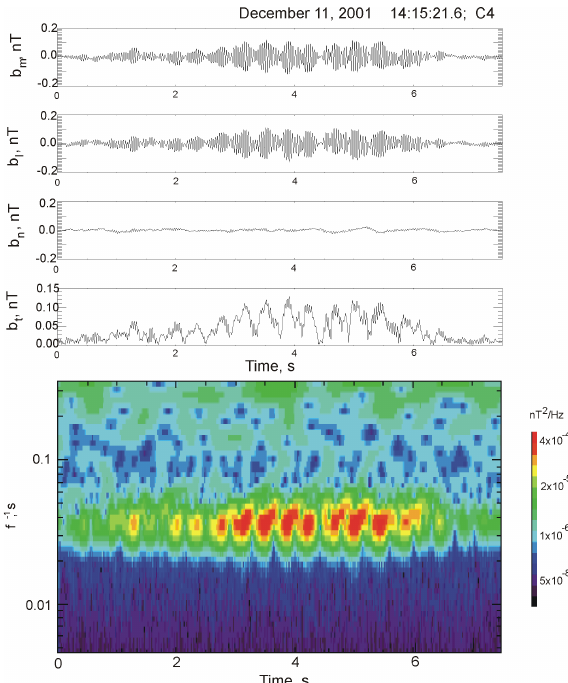
Fig. 6. The wave form of the magnetic field variations in ( m,l,n ) coordinates. The bottom panel shows the wavelet spectrogram of the observed